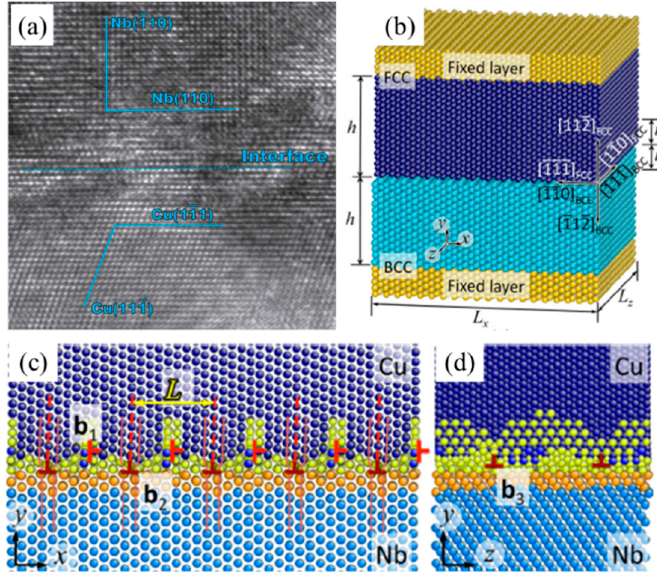
Figure 2. ( a ) HRTEM micrographs of the Cu/Nb interface in a PVD nanolayered composite; ( b ) Molecular simulation model of a Cu/Nb bi-layer. ( c ) and ( d ) are intrinsic defect structures (misfit dislocations) at the Cu/Nb interface [18].